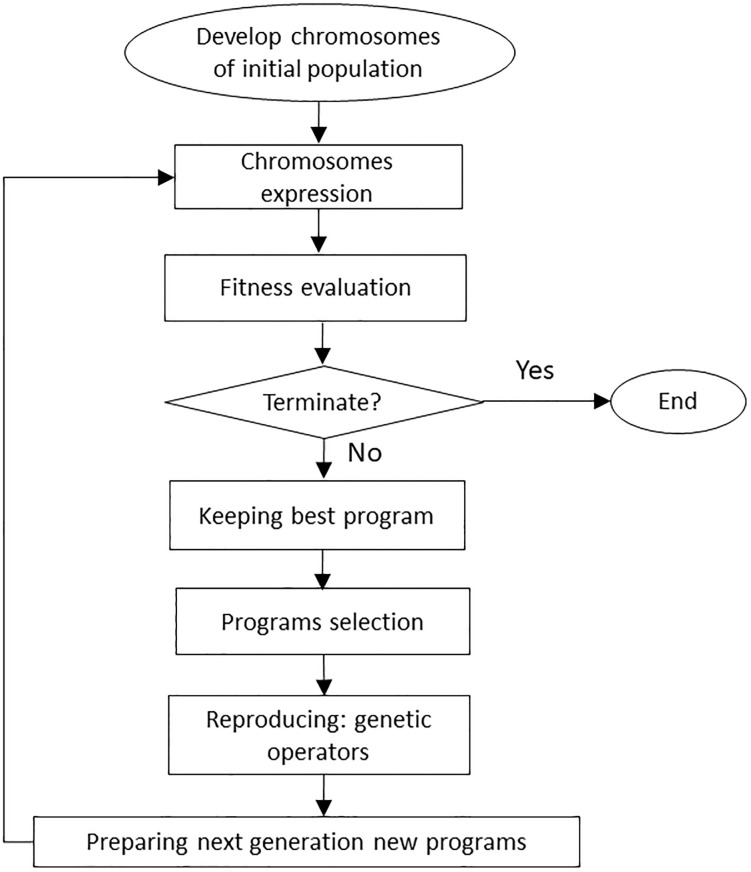
General structure and operation of the GEP model [66].